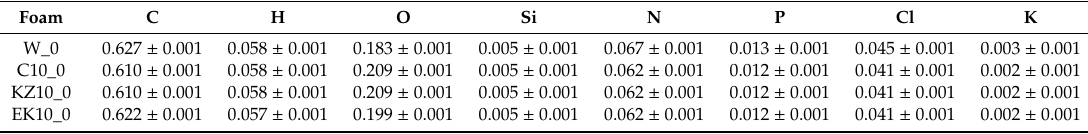
Table 9. Mass shares of individual elements in analyzed